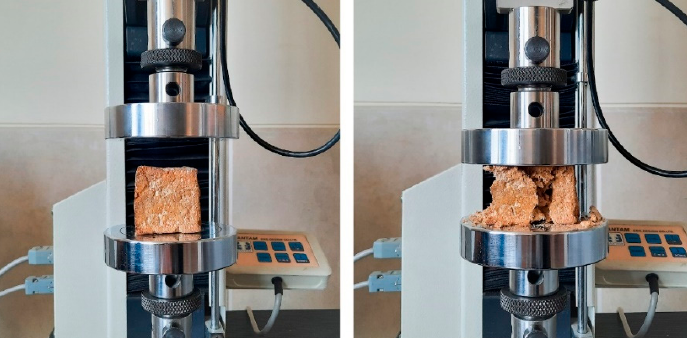
Figure 7. The Compressive Strength Test (Image credit: Authors).